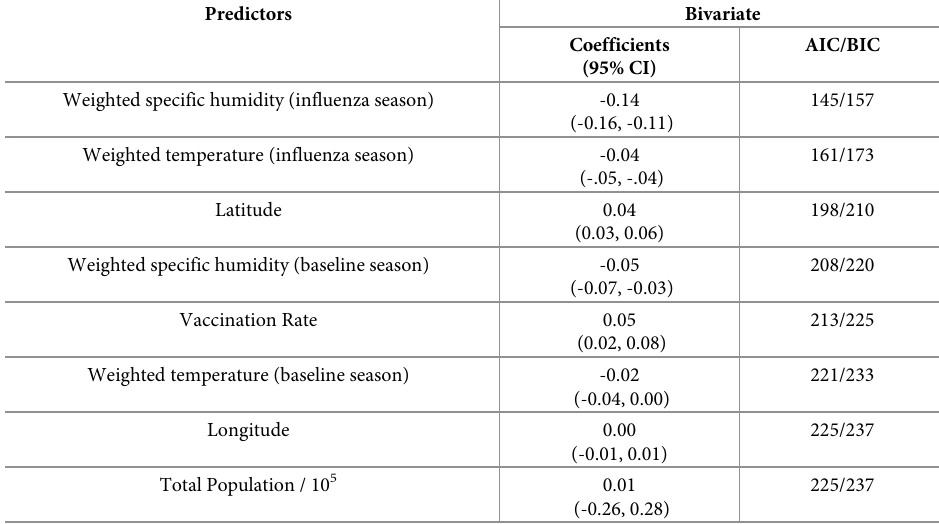
Table 3. Results of bivariate mixed-effects regression analysis where the log of the cross-seasonal ratio was the dependent variable. The models were sorted in ascending order by